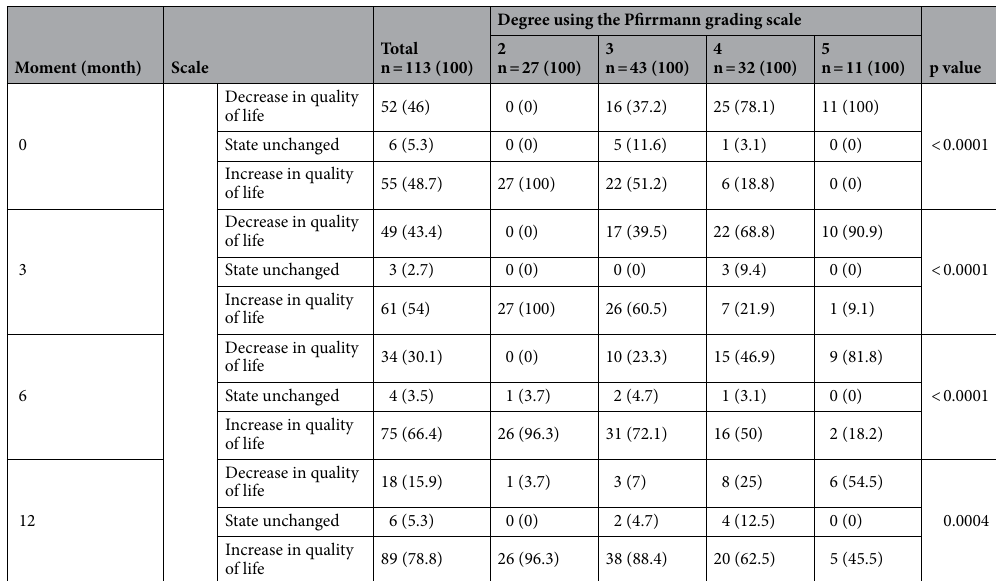
Table 4. Point-based assessment of pain intensity according to the VAS scale, degree of disability according to the ODI scale and quality of life according to the SWLS scale of patients qualified for the microdiscectomy procedure, overall and divided for each radiological degree of advancement of degenerative changes according to the Pfirrmann scale. Qualitative data are presented as numbers and percentages; p values were determined by the chi-squared test.